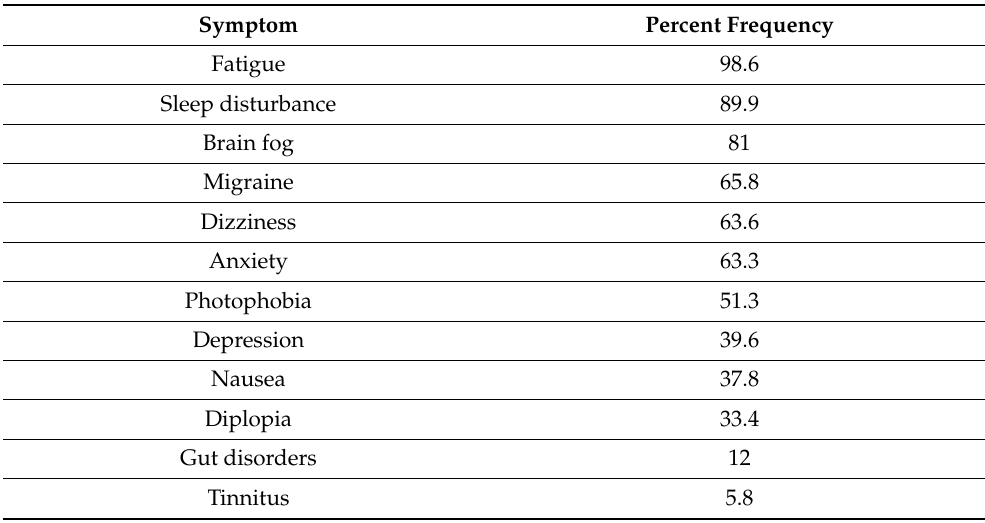
Table 3. Frequency of non-pain symptoms reported in the questionnaire by the Fibromyalgia patients ( n = 277).